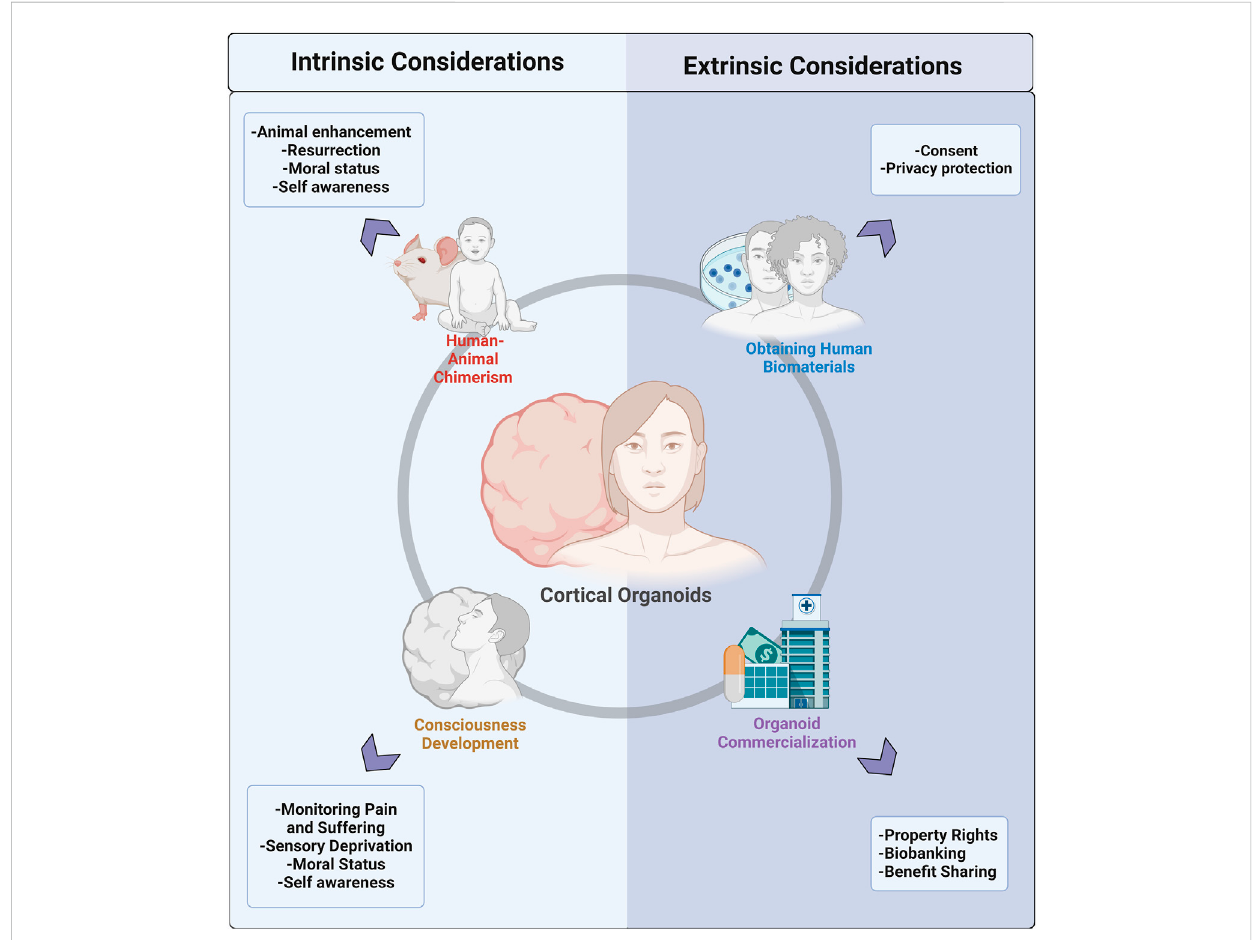
FIGURE 2 Pictural representation of the division of ethical and moral considerations for cerebral organoid technology into intrinsic and extrinsic factors. Intrinsic considerations include concerns that arise with the formation of human-animal chimeras and those that are associated with the potential for organoidstodevelopconsciousness invitro .Extrinsicconsiderationscanbedividedintoconcernsassociatedwiththeobtainmentofhumanbiomaterials needed to generate organoids and issues that arise with the growing commercialization of